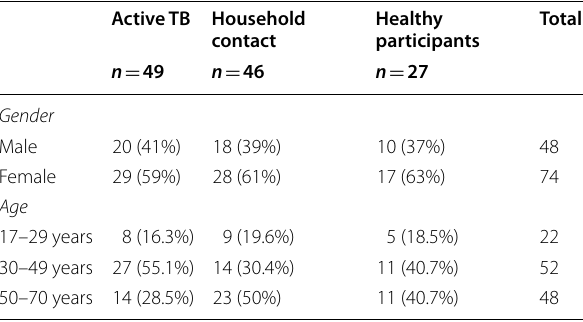
Table 1 Characteristics of the sample based on the active TB group, household contacts, and healthy controls